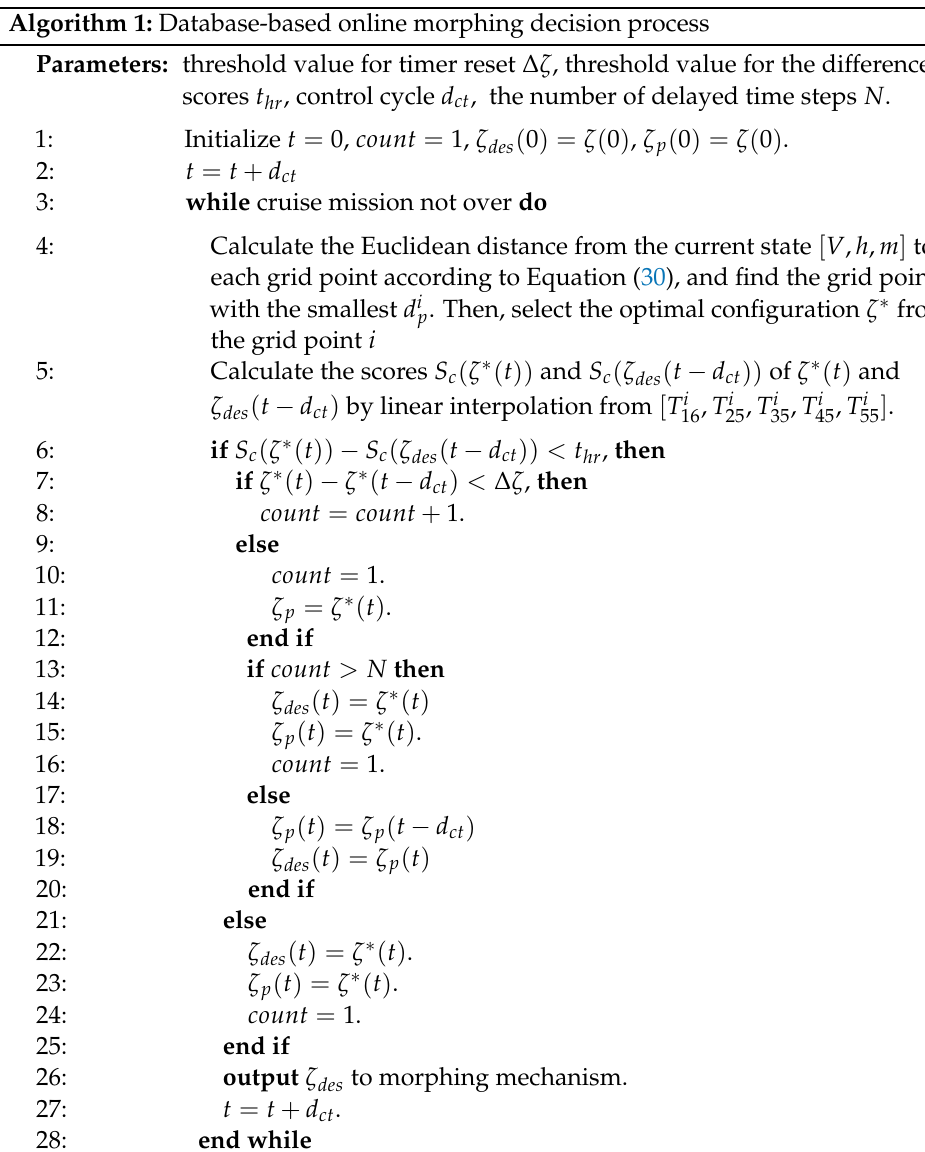
Algorithm 1: Database-based online morphing decision